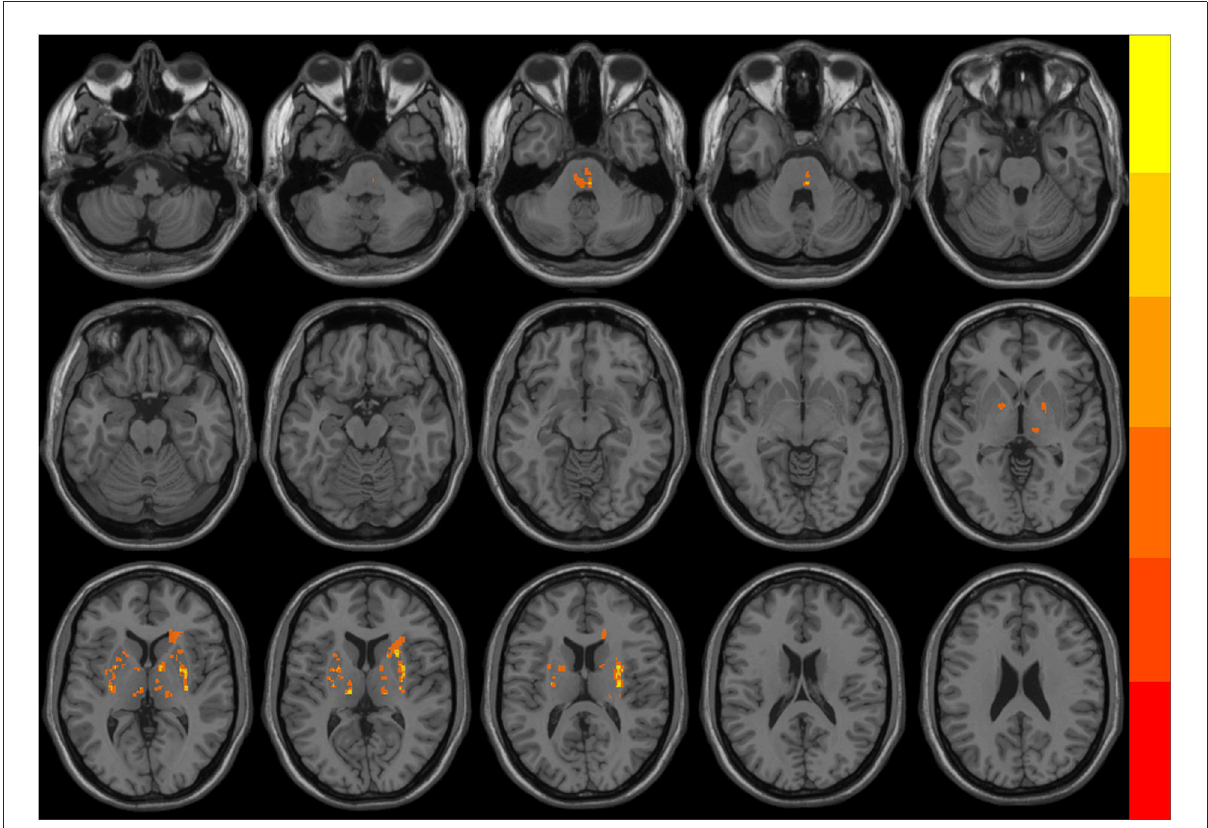
FIGURE1 The overlapping distribution map of ischemic stroke lesions in patients with post-stroke insomnia (PSI). Different colors indicate the number of overlapping lesions at different brain regions. The infarct lesions mostly located in the pons, bilateral basal ganglia, and thalamus.